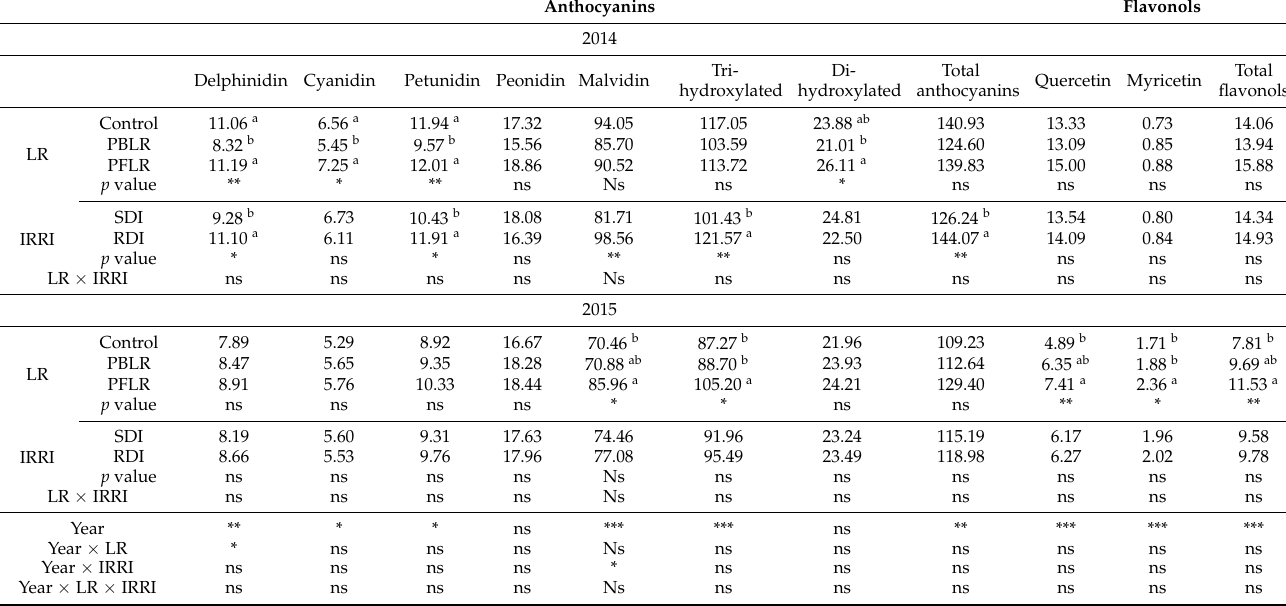
Table 3. Grape berry skin flavonoid concentration at harvest in a Merlot ( Vitis vinifera L.) vineyard in Denair, California in 2014 and 2015 a,b,c .